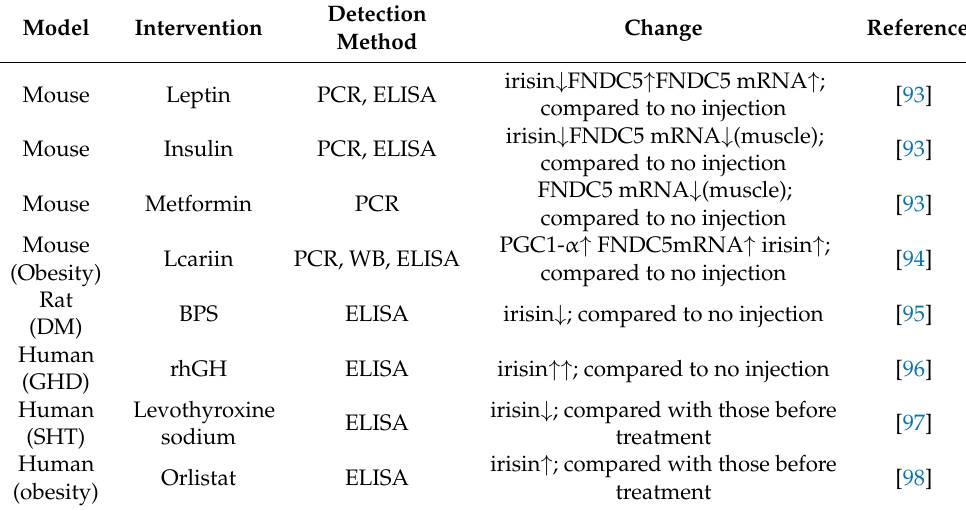
Table 2. The effects of drugs on the irisin